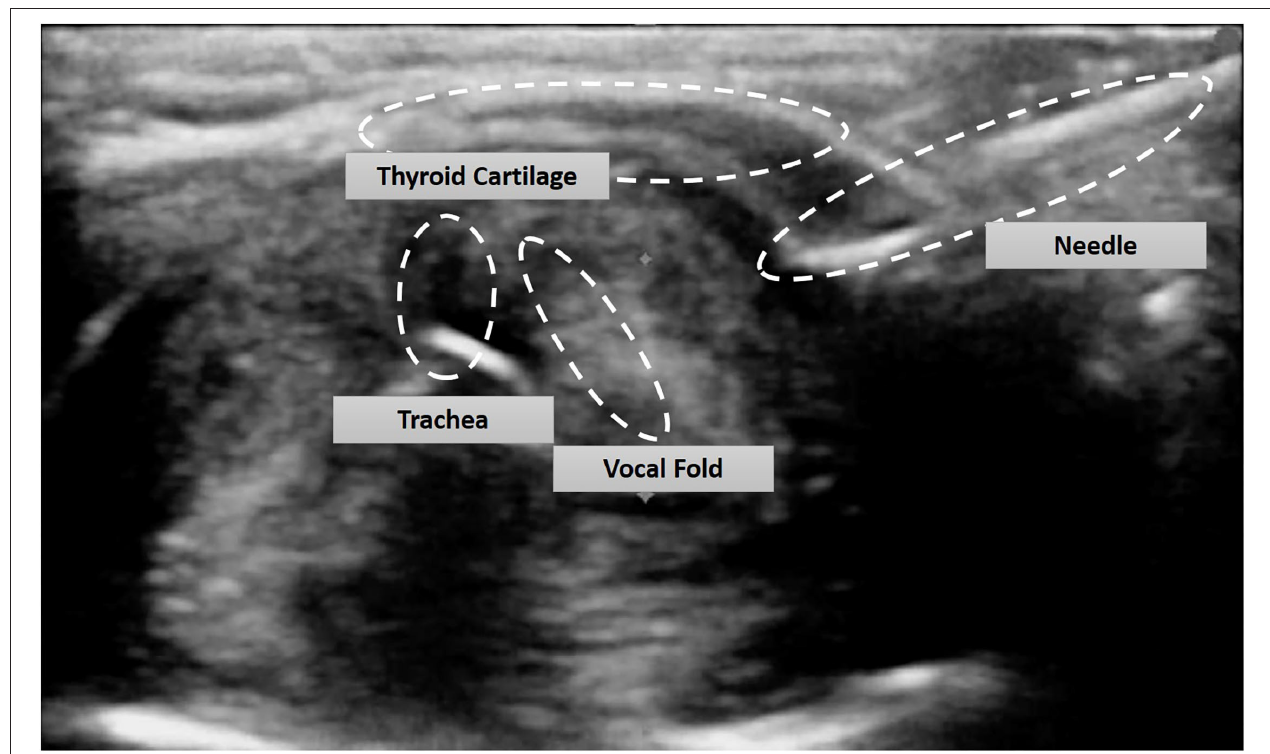
FIGURE 3 | Axial ultrasound of the larynx with in-axis placement of the 18G